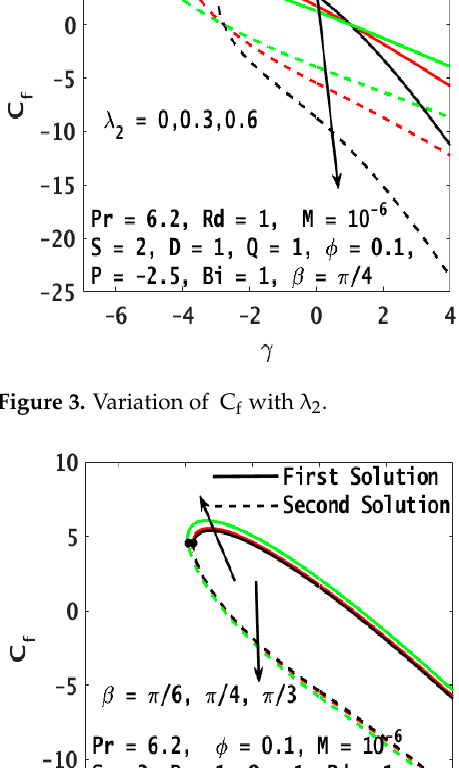
Figure 2. Variation of C (cid:2916) with D .